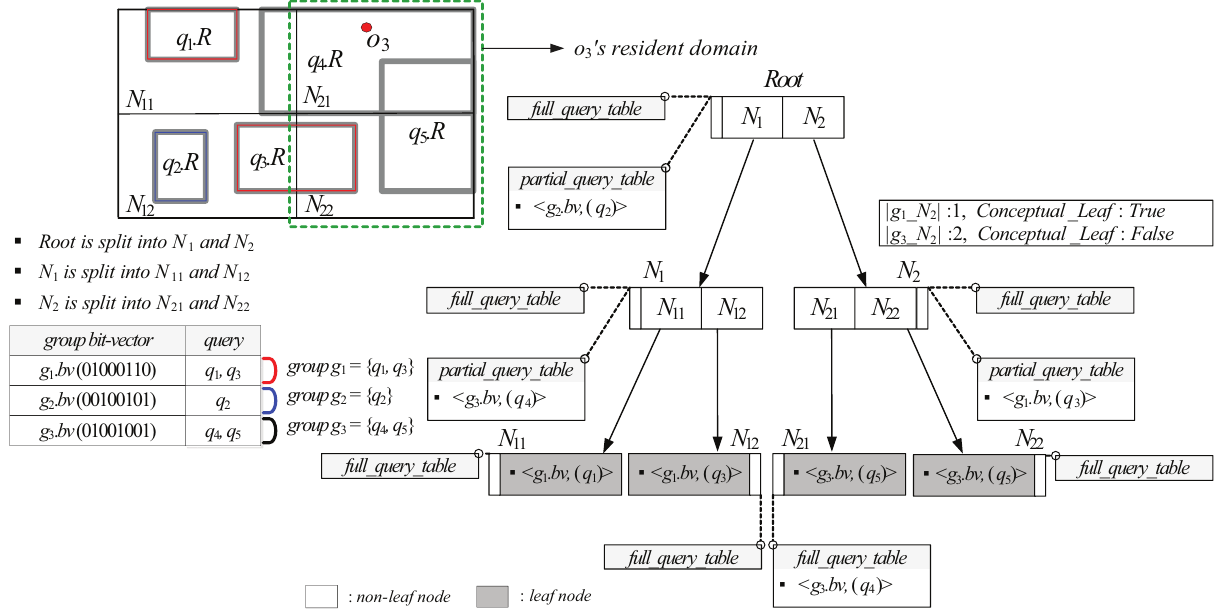
Figure 7. An example of the Group-Aware Query Region